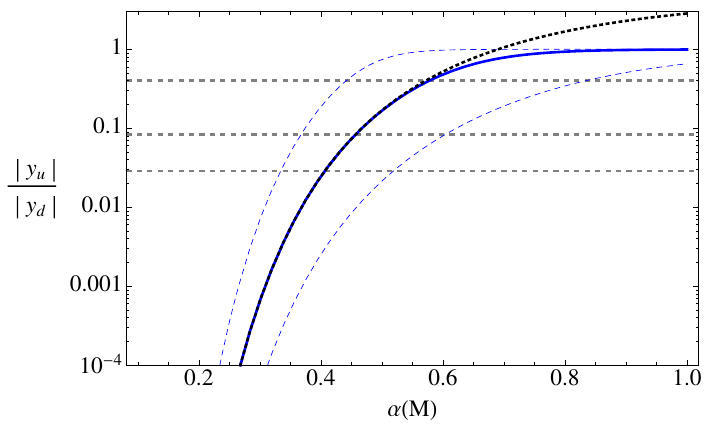
Figure 1 . The ratio of Yukawa couplings generated by instanton e(cid:11)ects as a function of (cid:11) = g 2 = 4 (cid:25) evaluated at the scale M in the 2-(cid:13)avor model assuming a vanishing perturbative value for one of the couplings. The solid curve cuts uses the full solution to eq. (2.5), cutting o(cid:11) the running at (cid:22) = M . The dashed curves cut o(cid:11) the instanton e(cid:11)ects at (cid:22) = M= 2 ; 2 M , and are shown as a rough estimate of the theoretical uncertainty. The dotted line is the single-instanton approximation eq. (2.6). The horizontal dashed lines are, from top to bottom, the experimental values of y u =y d , y s =y c , and y b =y t